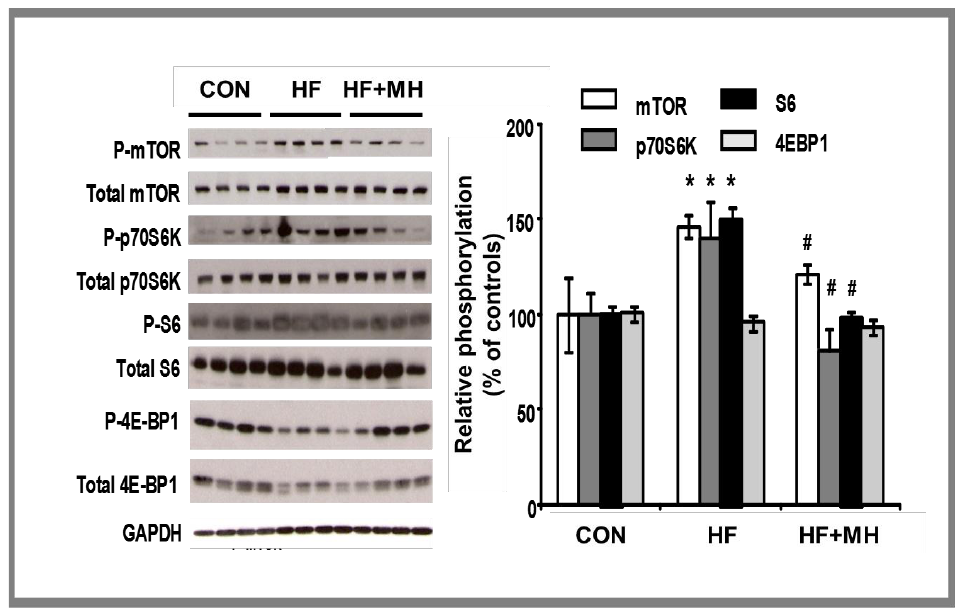
Figure 9. Protein levels of signaling events in the mTOR pathway (S6, p70S6K, 4EBP1) measured in white adipose tissue in mice after 9 months on diets. # = p < 0.05, *= p < 0.01, compared to controls (Ns = 4).